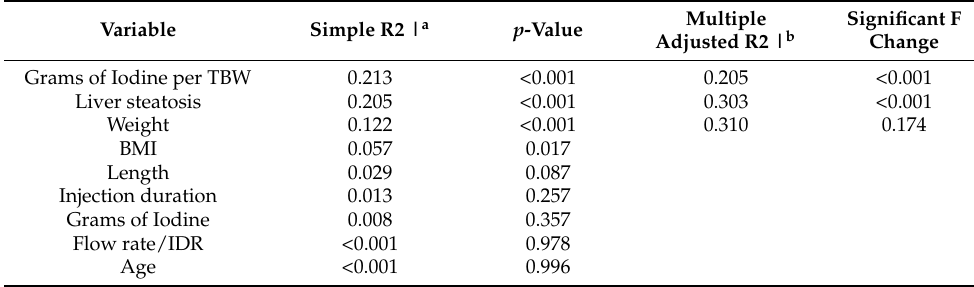
Table 5. R 2 in single and multiple linear